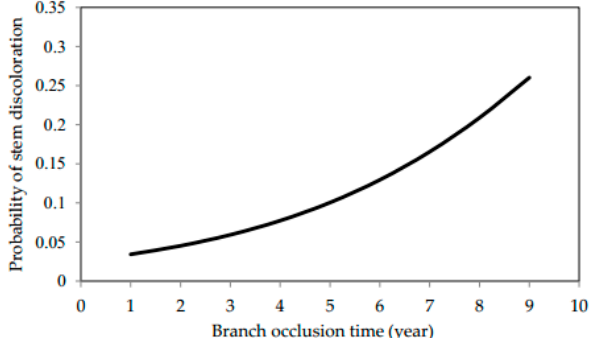
Figure 7. Predicted probability of wood discoloration for M. laosensis and the branch occlusion time.